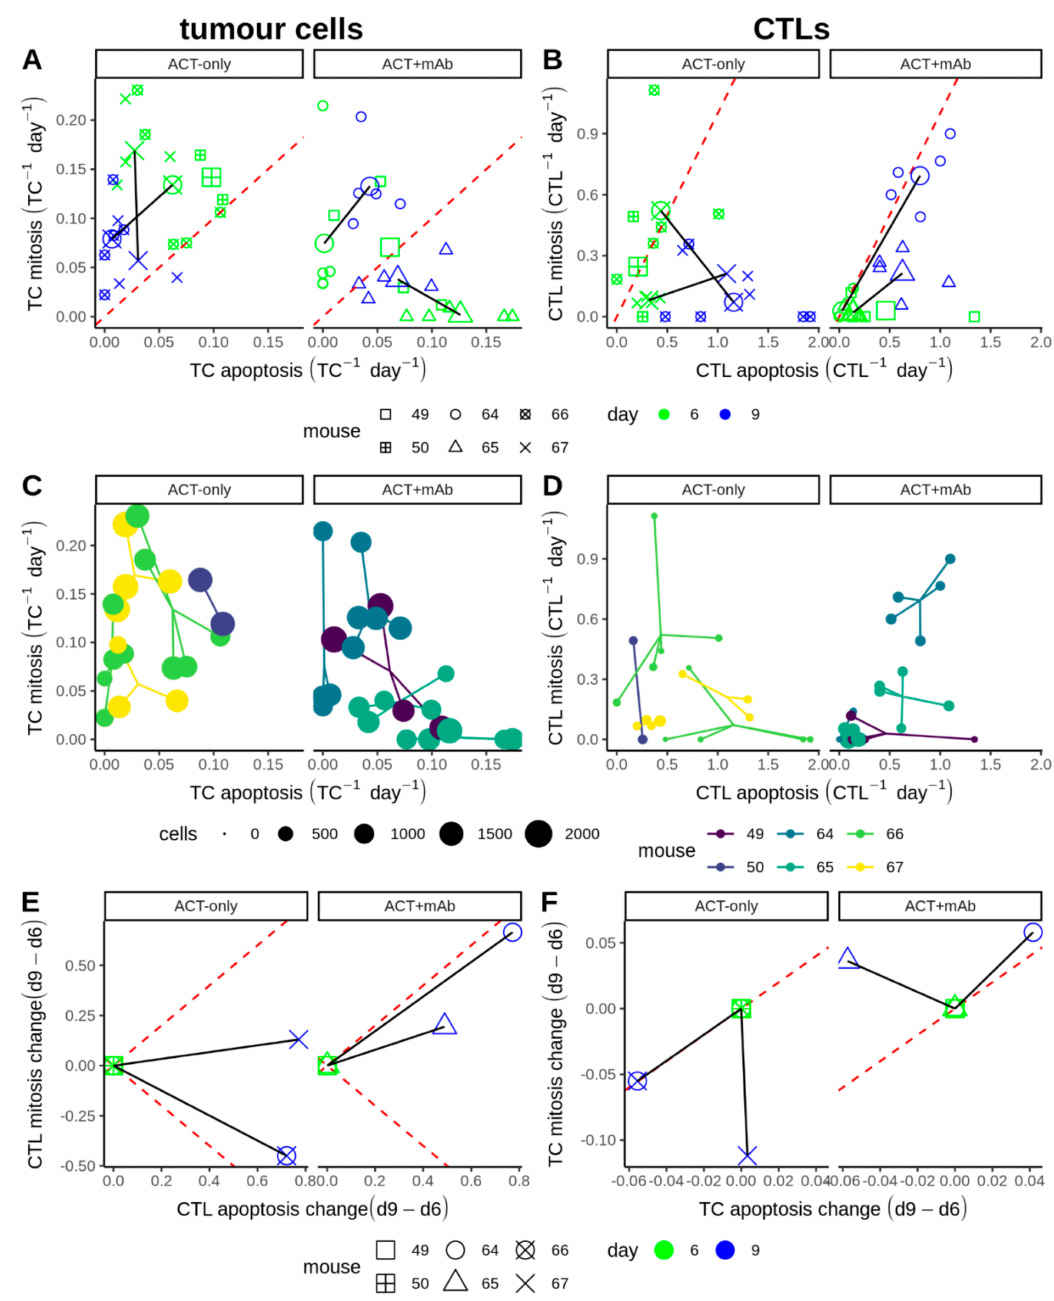
Figure 1. Comparison of apoptosis and mitosis rates for tumour cells and CTLs. ( A , B ) Apoptosis and mitosis rates of tumour cells ( A ) or CTLs ( B ) with or without anti-CD137 (columns). Each small point represents two simultaneous apoptosis ( x -axis) and mitosis ( y -axis) rates measured at one site within a tumour. Points are coloured based on the day of measurement, and different mice are indicated by shape. Large points are the mean values per position/day; these are connected by solid black lines for cases where we have intravital measurements on both days 6 and 9 from the same mouse. The red dashed line marks net zero population growth. ( C , D ) Apoptosis and mitosis rates of tumour cells ( C ) or CTLs ( D ) where point size indicates the total number of cells recorded per site. Segments connect all points from the same mouse imaged on the same day. Each colour represents a different mouse. ( E , F ) Change in the apoptosis and mitosis rates of tumour cells ( E ) or CTLs ( F ) based on intravital data for two mice per condition (constructed via linear translation of the mean values in A , B such that the day 6 measurement lies at the origin). Points are coloured based on the day of measurement, and different mice are indicated by